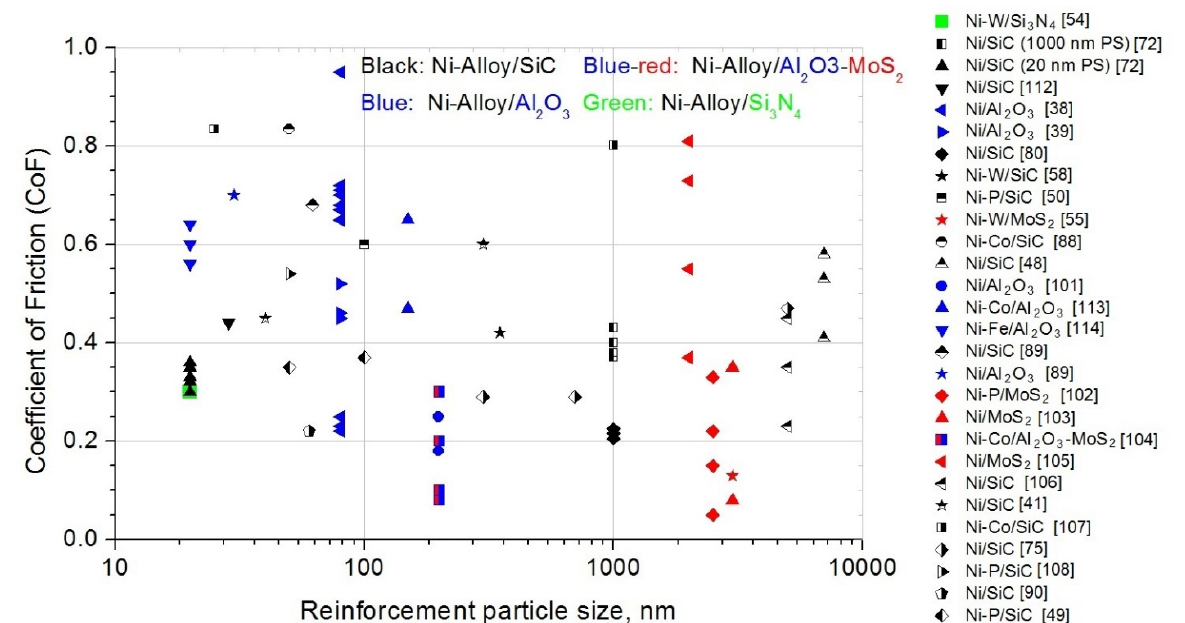
Figure 6. The effect of reinforcement particle size on the CoF in Ni-alloy MMCs. The CoF graph includes only dry friction measurements at room temperature for MMCs without annealing.